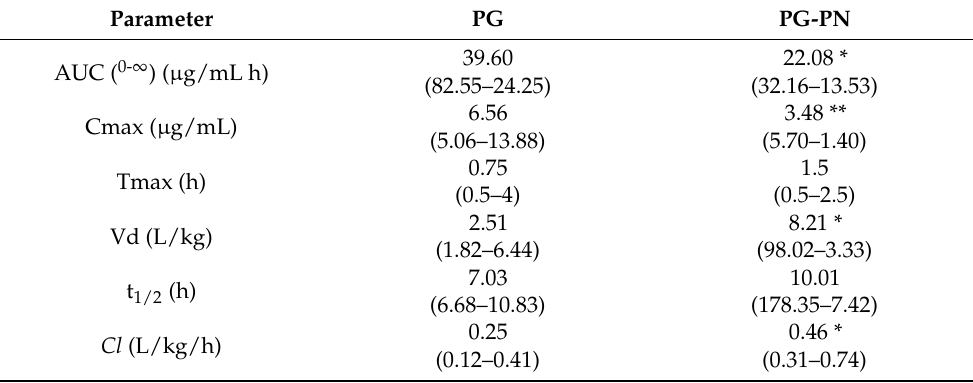
Table 1. Estimated pharmacokinetic parameters after oral administration of PG and PG-PN (10 mg/kg) in rats (n = 6, for each profile). Data expressed as median, CI = 95%.